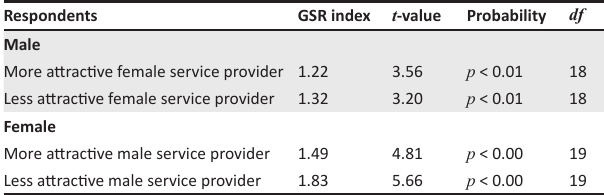
TABLE 1: Galvanic skin response results.